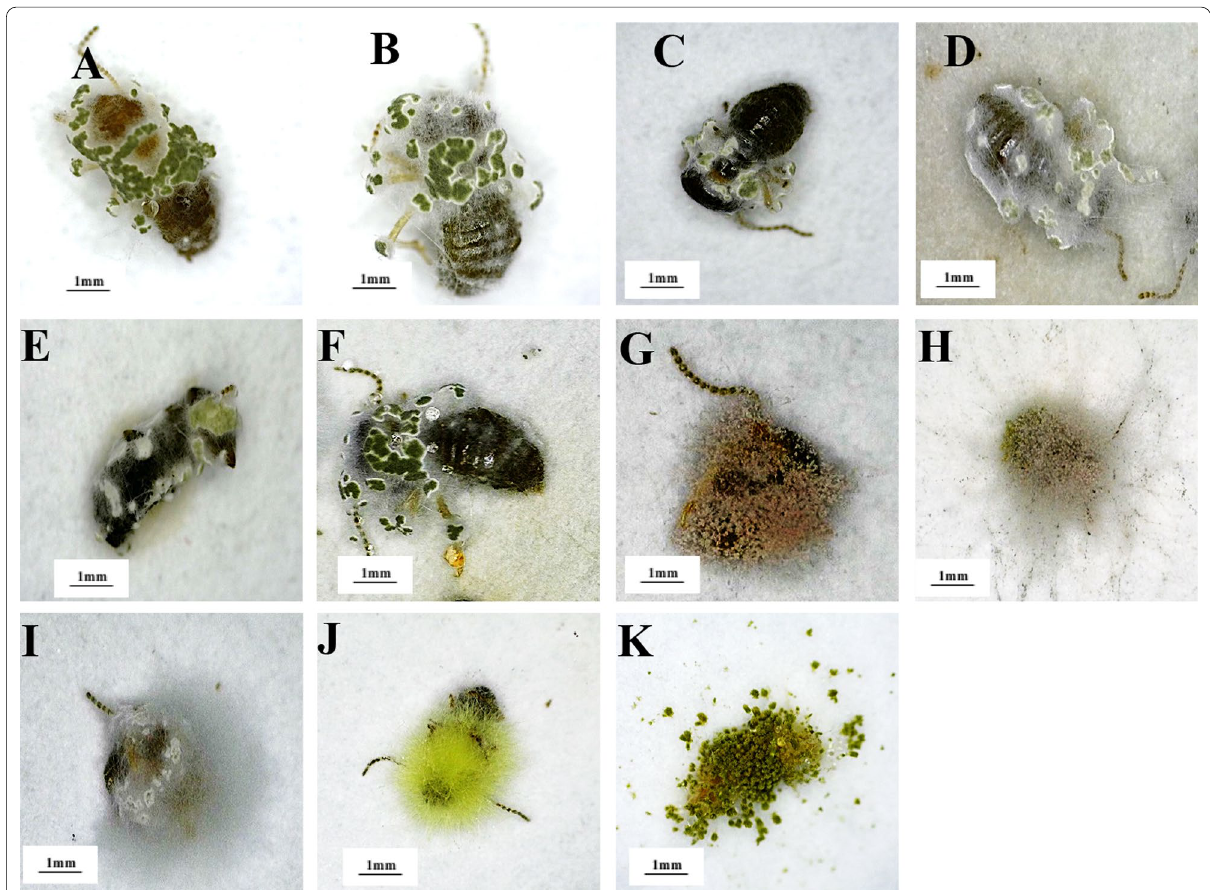
Fig. 5 Mycelia grown on the carcass of Coptotermes curvignathus . A UPM-A2C-1 Metarhizium anisopliae var anisopliae , B UPM-A3C-1 M. anisopliae var anisopliae , C UPM-A3C-2 M. anisopliae var anisopliae , D UPM-A5C-1 M. anisopliae var anisopliae , E UPM-10C-1 M. anisopliae var anisopliae , F UPM-A13C-2 M. pinghaense , G UPM-A7C-1 Purpureocillium lilacinum , H UPM-A2C-3 P. lilacinum , I UPM-A2C-5 Cordyceps javanica , J UPM-A1C-1 Aspergillus auricomus , K UPM-A1C-2 A. caelatus . These images were observed using Dino-Lite Digital Microscope and the image were taken using the DinoXcope 2.0 software